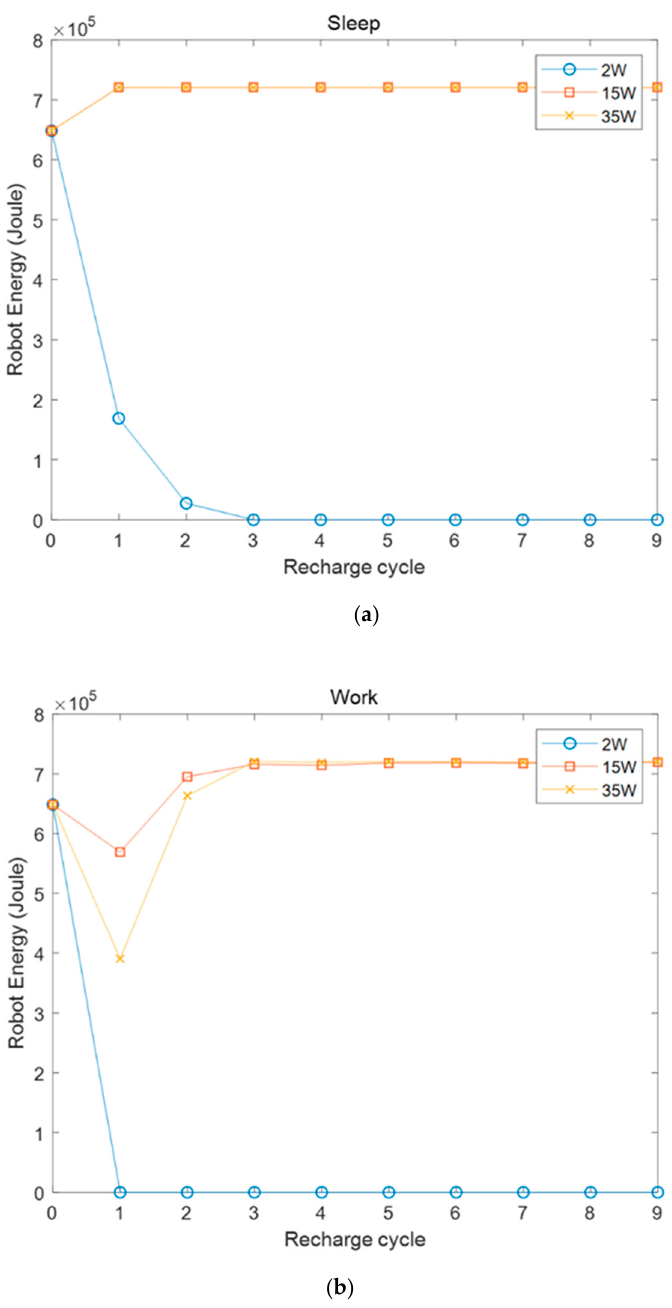
Figure 5. Robot energy after charge cycle. ( a ) Robot energy: sleep state maintained before charging; ( b ) Robot energy: work and sleep if necessary before charging.